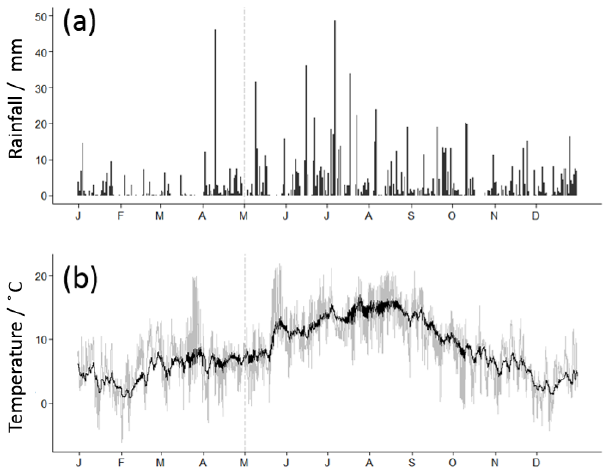
Figure 3. (a) Accumulated daily rainfall at the Easter Bush Field site during the year 2012. (b) Air temperature at height 3m (grey) and soil temperature (black) recorded at the Easter Bush field site during the year 2012. Tillage occurred on 1 May 2012 (grey dashed vertical